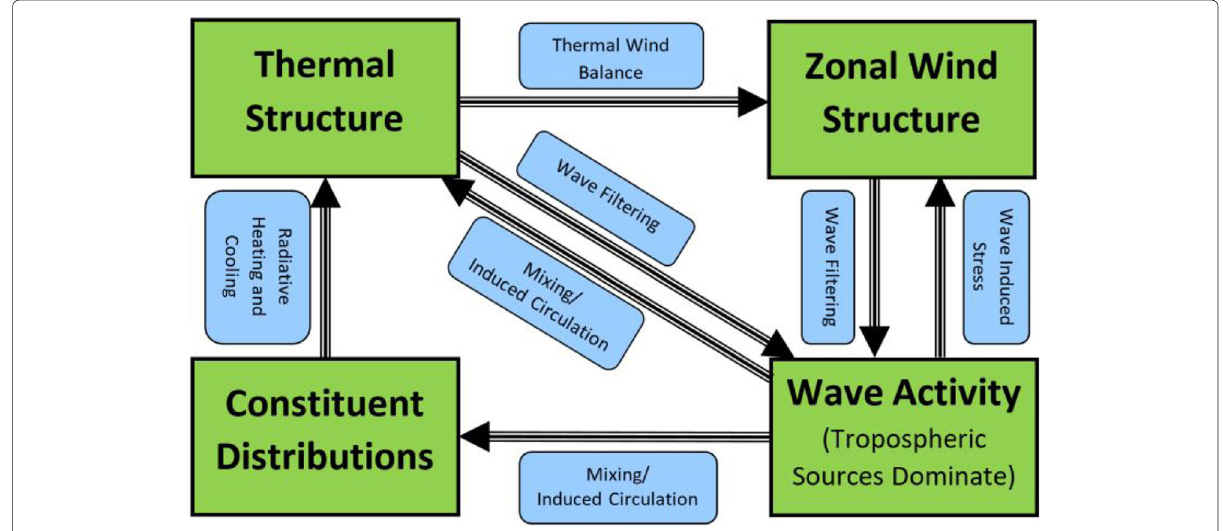
Fig. 1 Links in the middle atmosphere. A schematic showing the relationship between various components affecting the large-scale structure of the middle atmosphere. The main elements appear in the green boxes, and the processes linking them appear in the blue boxes. The arrows indicate the direction of the influence. Although thermal wind balance links the zonal mean temperature and wind structure, wave and constituent fields affect the heating and momentum deposition leading to these structures and themselves depend non-linearly on these large-scale